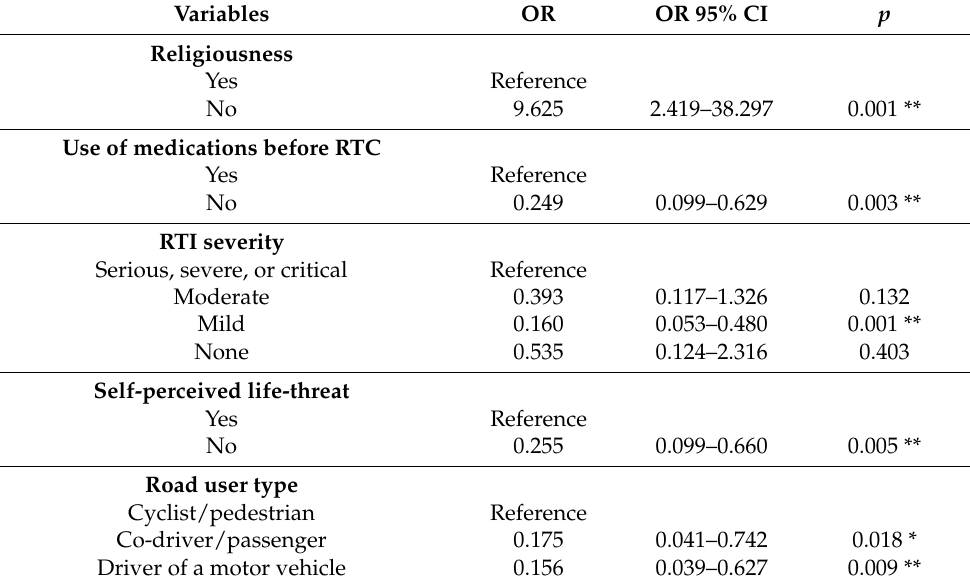
Table 4. The multivariable regression model for depression symptoms at 1-month follow-up. Variables OR OR 95% CI